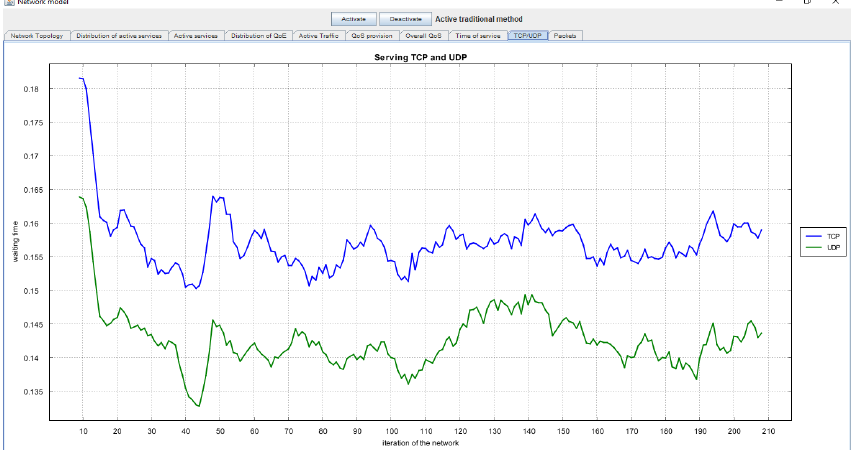
Figure 31. The average waiting time for TCP/UDP (Transmission Control Protocol, User Datagram Protocol) services using the traditional method.